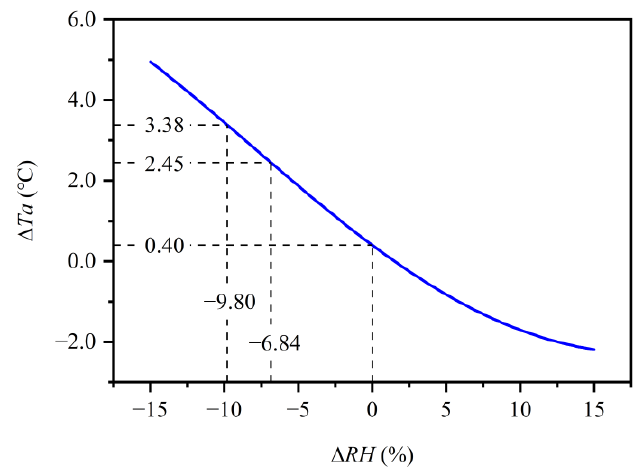
Figure 8. Air Temperature Difference (∆ Ta ) varying with Relative Humidity Difference (∆ RH ) at ∆ X = 30 m.